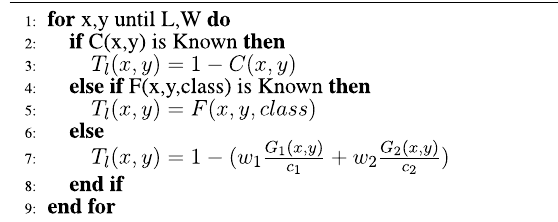
Algorithm 1. Hierarchical traversability value calculation